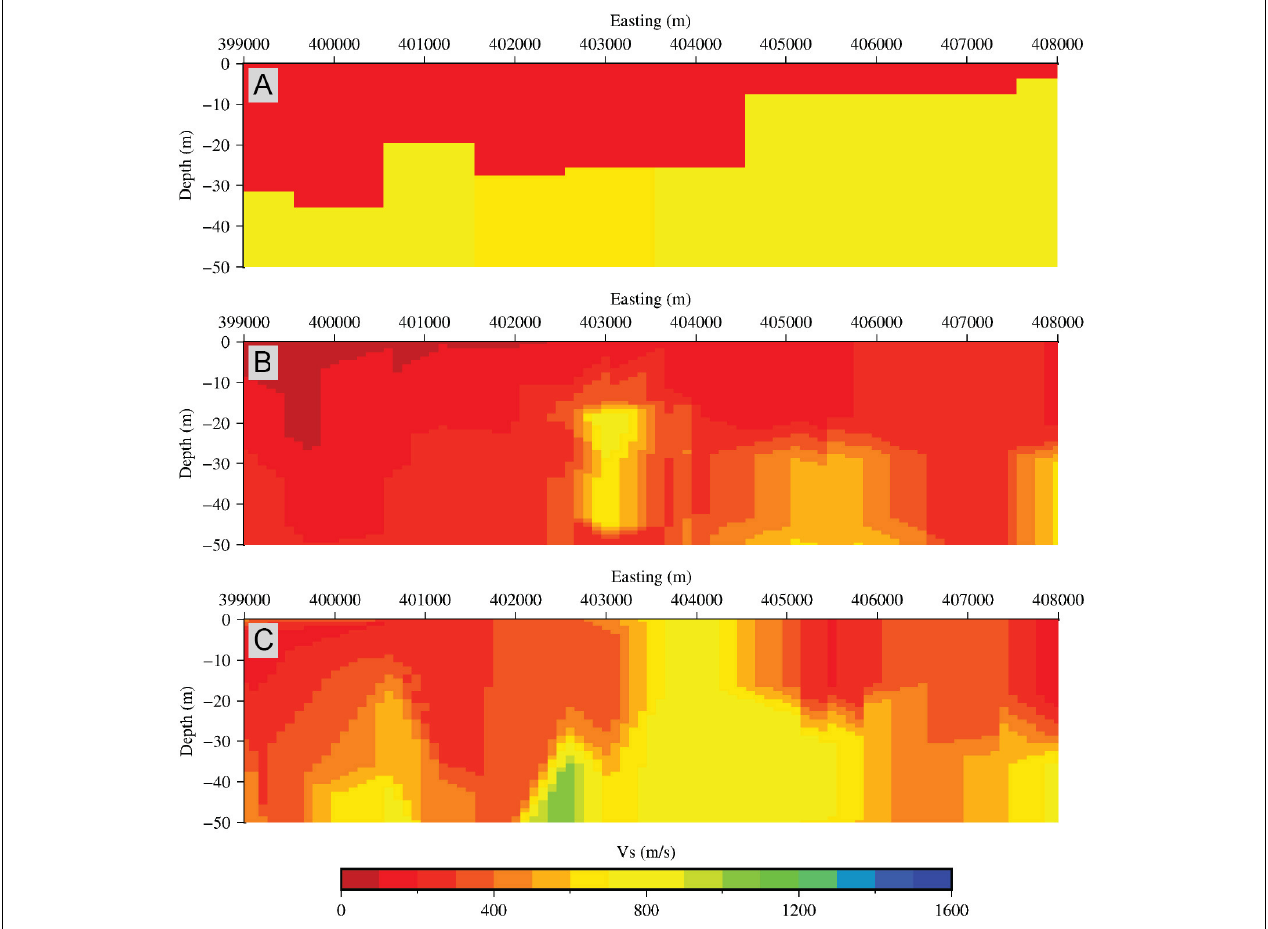
FIGURE 10 | (A) Proposed Vs structure of Mataram City digitized from the study done by Marjiyono (2016b) which is used as a reference model in this study. (B) Vertical cross-section of Vs structure from the result of the inversion process of FFT-HVSR curves. (C) Same with point (B) but for HHT-HVSR